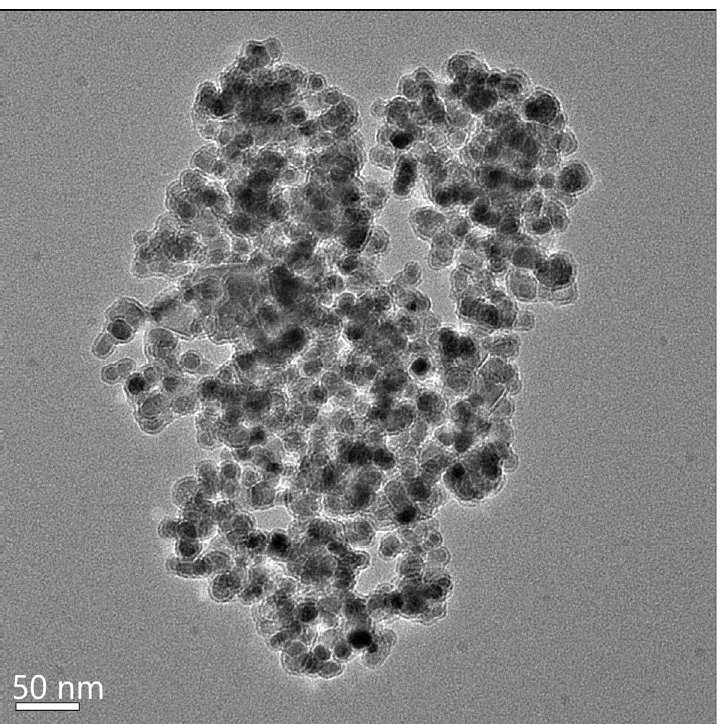
Figure 5. TEM ‐ image of MNPs with silica coverage (the results obtained in the laboratory of the presenting authors).